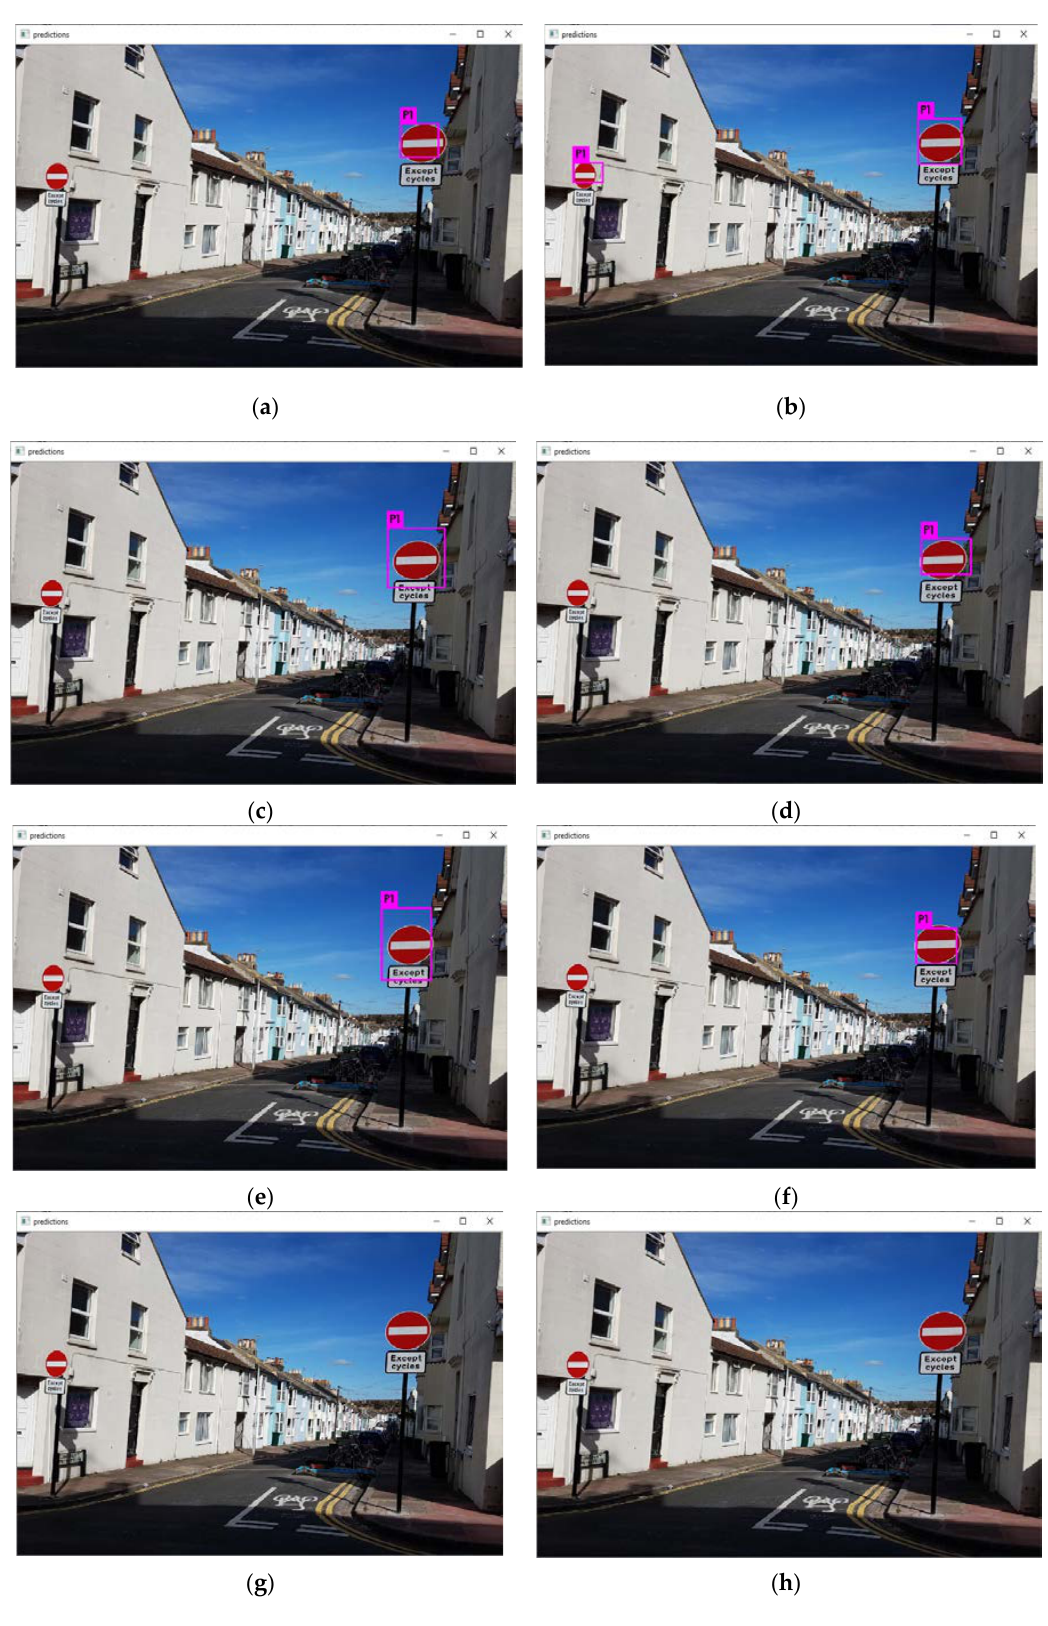
Figure 11. Taiwan’s prohibitory sign (Class P1) recognition result using ( a ) Yolo V3, ( b ) Yolo V3 SPP, ( c ) Densenet, ( d ) Densenet SPP, ( e ) Resnet 50, ( f ) Resnet 50 SPP, ( g ) Tiny Yolo V3, and ( h ) Tiny Yolo V3 SPP.